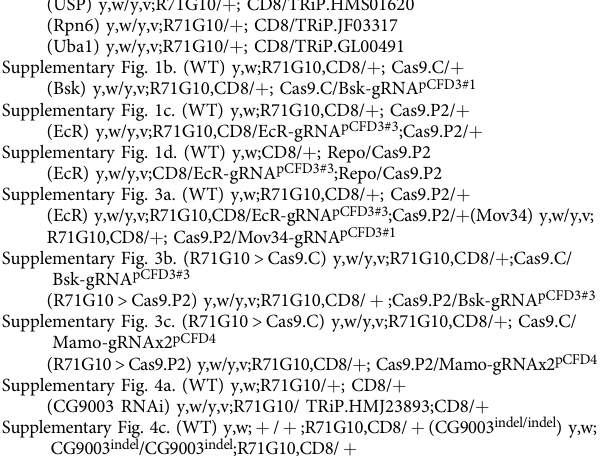
Detailed Drosophila genotypes . Genotype abbreviations: R71G10 is GMR71G10- GAL4, 201Y is 201Y-GAL4, Repo is Repo-GAL4, CD8 is 10XUAS-mCD8::GFP,